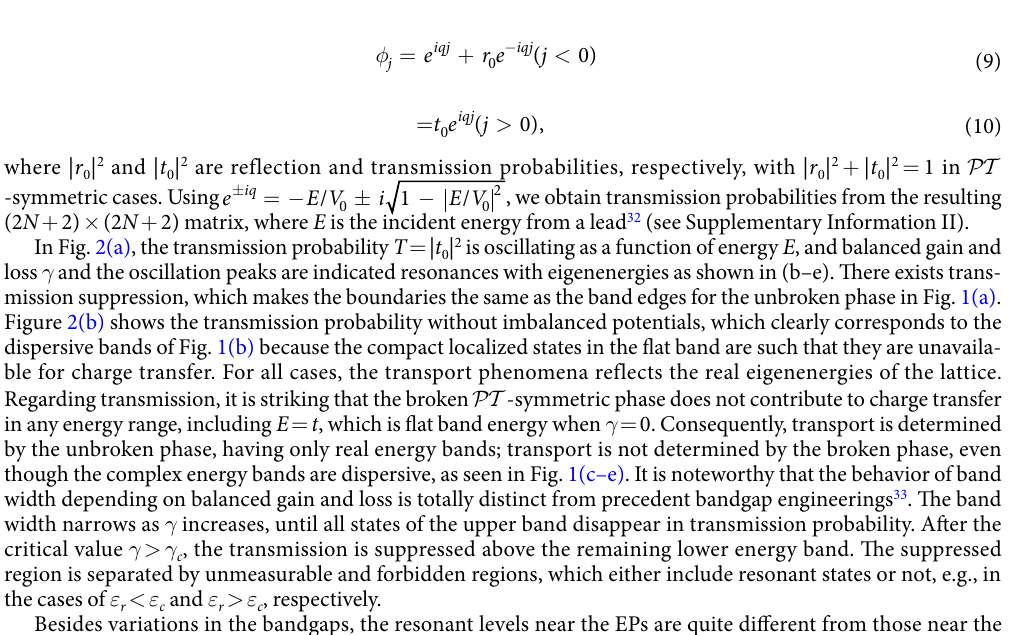
Figure 2. ( a ) Transmission probabilities in the CS lattice with N = 100 unit cells in ( γ , E ) space. Red curves represent high transmission probabilities corresponding to the resonant modes in the finite PT -symmetric CS lattice. As γ increases, band width decreases and bandgap increases. Ultimately, the upper band disappears when γ > γ c = 2. ( b – e ) Transmission probabilities with different γ . As E approaches the band edges, the spacings between transmission peaks narrow because of the high density of states. We fix g = 1 and V 0 = 10 throughout this